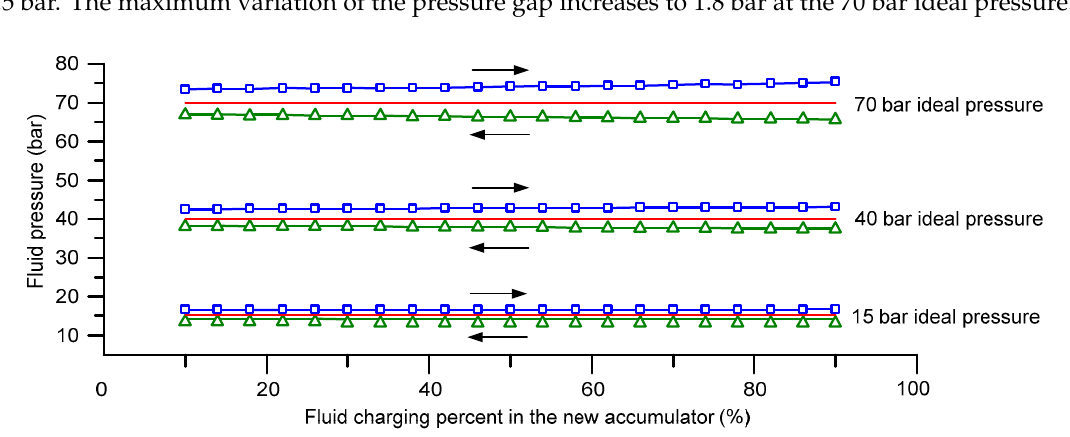
Figure 8. The fluid pressure of the new accumulator with a 0.02 m/s piston speed.